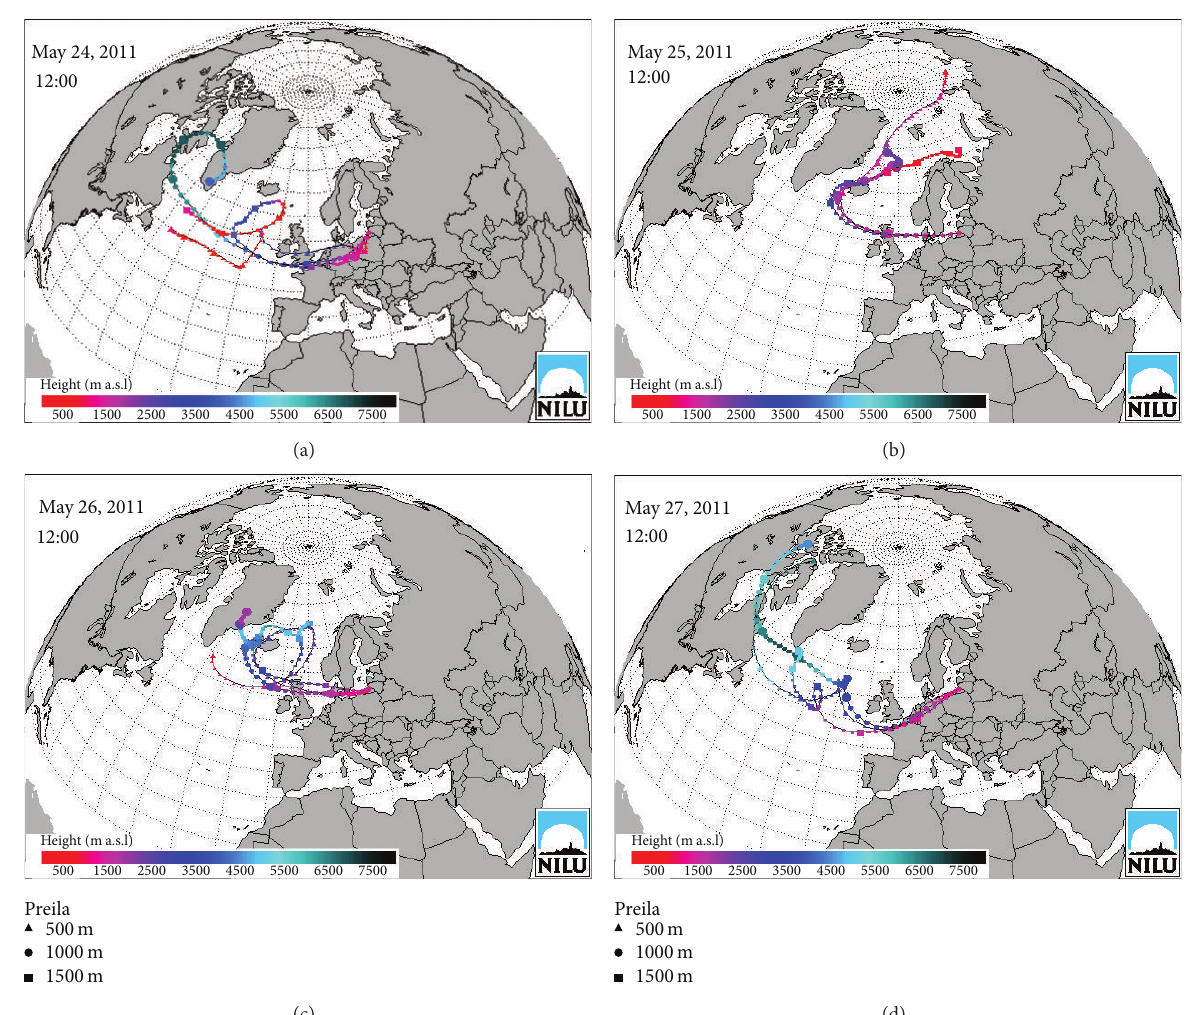
Figure 4: Backward trajectories of the air masses from the volcano at Grimsv¨otn to Lithuania on 24–27 ((a)–(d)) May 2011 (12:00